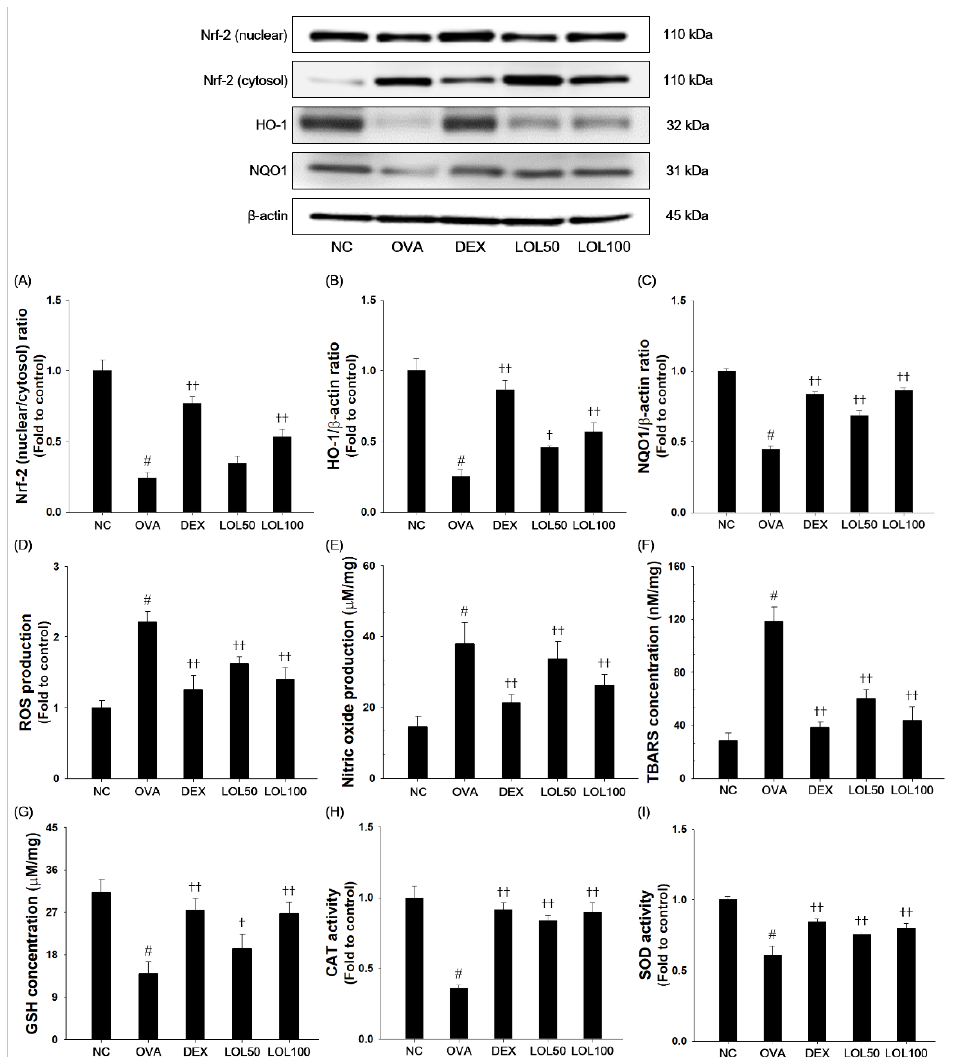
Figure 6. Effects of LOL on OVA-challenged Nrf-2 pathway and oxidative stress. The ( A ) Nrf-2, ( B ) HO-1 and ( C ) NQO1 in the lung tissues were analyzed by western blot ( β -actin: loading control). The levels of ( D ) ROS and ( E ) NO, contents of ( F ) TBARS and ( G ) GSH, and activities of ( H ) CAT and ( I ) SOD were determined in the lung tissues. NC: normal control mice; OVA: OVA-challenged asthma mice; DEX: dexamethasone (3 mg/kg) + OVA-challenged asthma mice; LOL: LOL (50 or 100 mg/kg) + OVA-challenged asthma mice. The values are expressed as the means ± SD ( n = 7/group). # P < 0.01, significantly different from NC group; †,†† P < 0.05, P < 0.01, significantly different from OVA-challenged group.